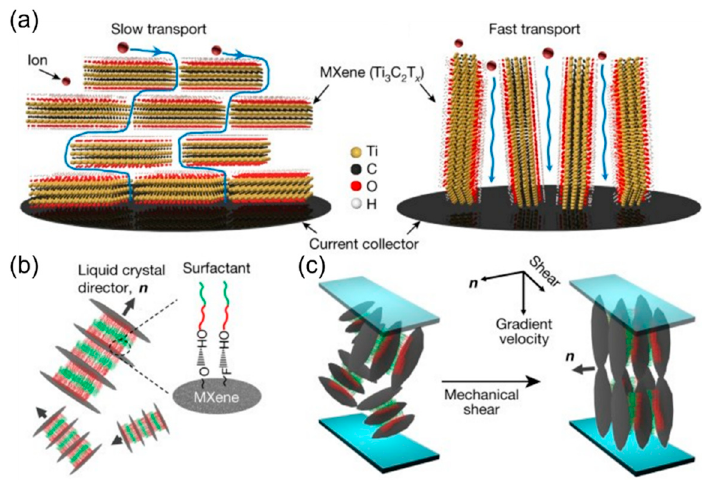
Figure 9. ( a ) Ion pathways in horizontally and vertically aligned MXene films. ( b ) The laminated structure of the MXene and surfactant with the hydrophilic (in red) and hydrophobic part (in green). ( c ) The shear-force-assisted vertically aligned MXene-based lamellar structure. Reproduced with permission from ref. [109]. Copyright 2018, Springer Nature.